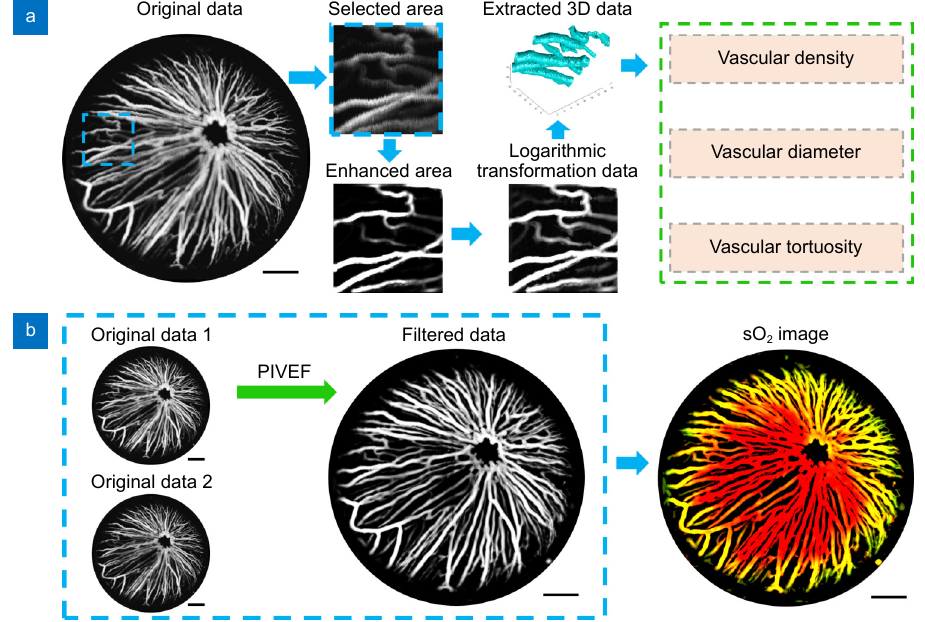
Fig. 2 | ( a ) The flow chart of vascular morphologic information analysis. ( b ) The flow chart of vascular functional imaging; Scale bar=0.5